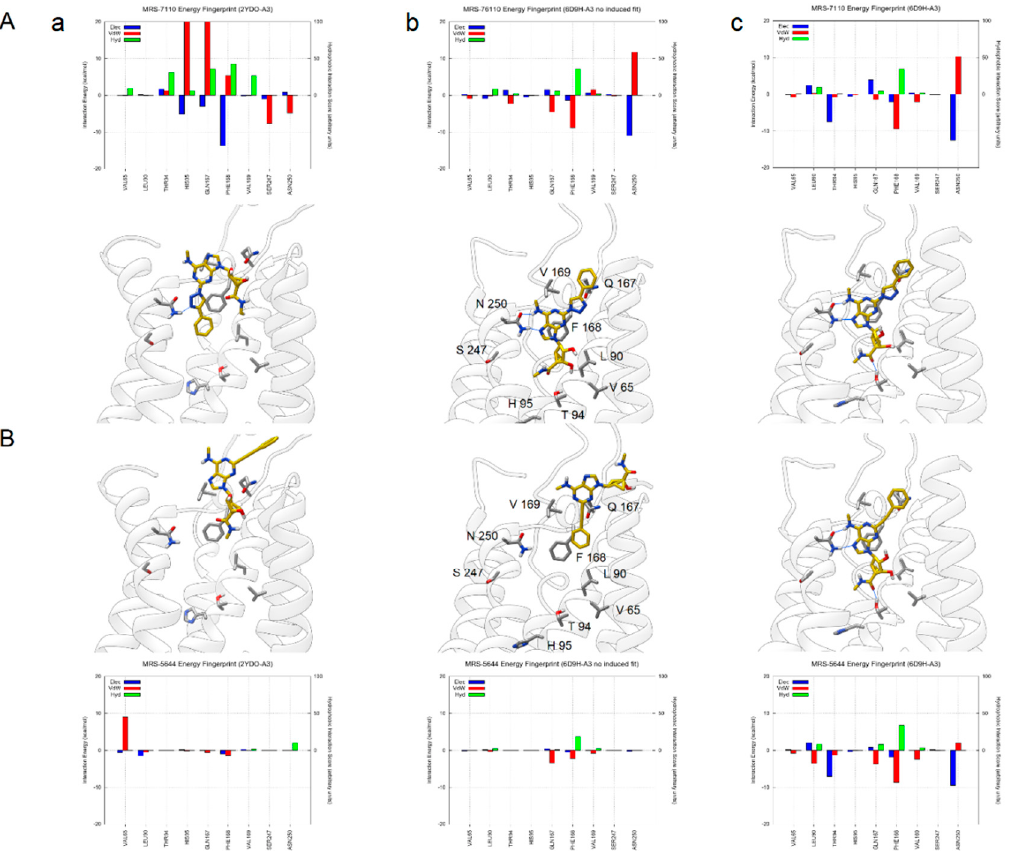
Figure 8. Per residue energy histograms and selected docking poses of MRS7110 (panel A ) and MRS5644 (panel B ) on either the hA 2A based model ( a ) or the hA 1 based models ( b , c ).